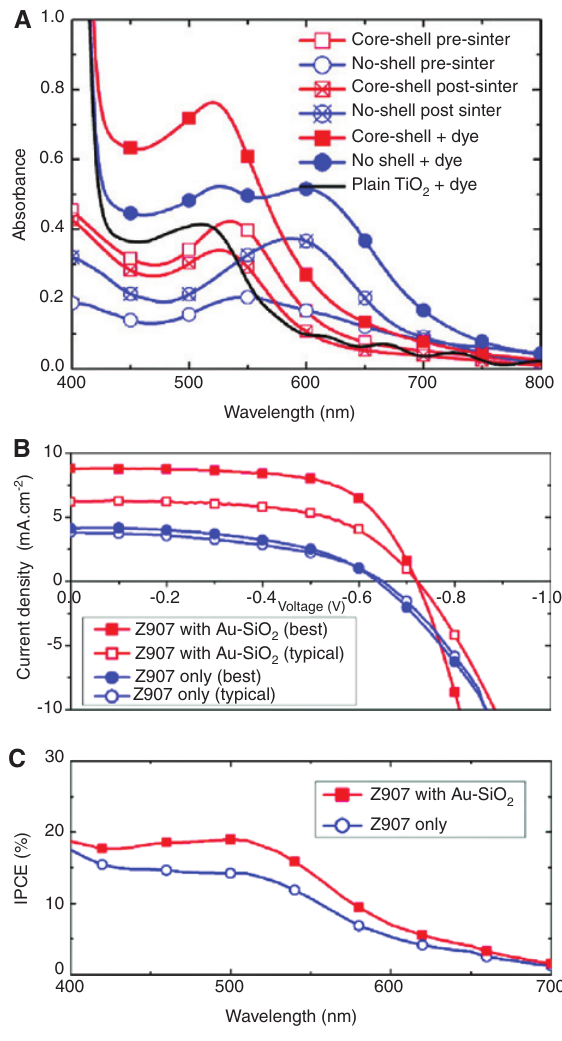
Figure 11: (A) Absorption spectra of thin films ( ~ 1 μ m) processed with conventional mesoporous TiO paste at different stages in 2 the fabrication process; directly after doctor blade coating (open symbols, “pre-sinter”), after two thermal sintering cycles at 500 ° C and a chemical TiCl treatment (open symbols with cross-through, 4 “post-sinter”), and with final dye-sensitization with Z907 ruthenium complex (solid symbols). (B) Current density voltage curves meas- ured under simulated AM1.5 sun light at 100 mWcm -2 for devices with Z907 dye-only and combined Au-SiO and Z907 sensitization. 2 (C) Incident photon-to-electron conversion efficiency (IPCE) spectra for a typical Z907 dye-only sample and a sample with the additional coating of Au-SiO nanoparticles after dye-sensitization, but prior to 2 hole-transporter coating. The curves for both a typical and the best device from the series are shown for both systems. Reprinted with permission from [72]. Copyright 2011 American Chemical